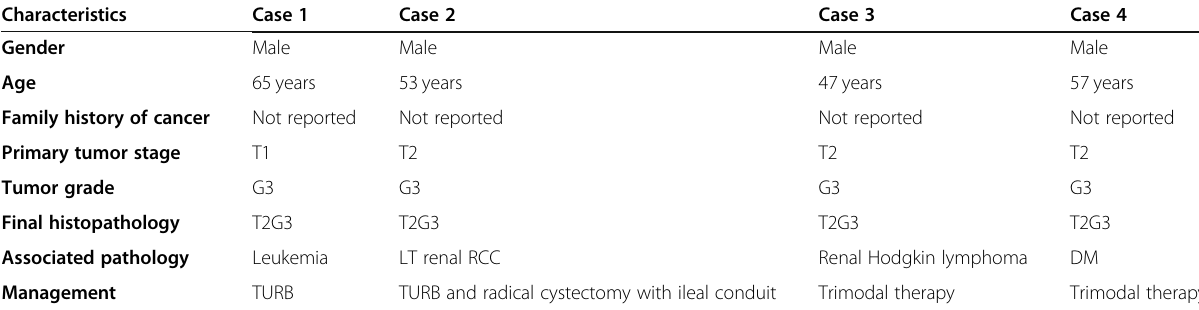
Table 1 Demographic and clinicopathological characteristics for bladder cancer cases